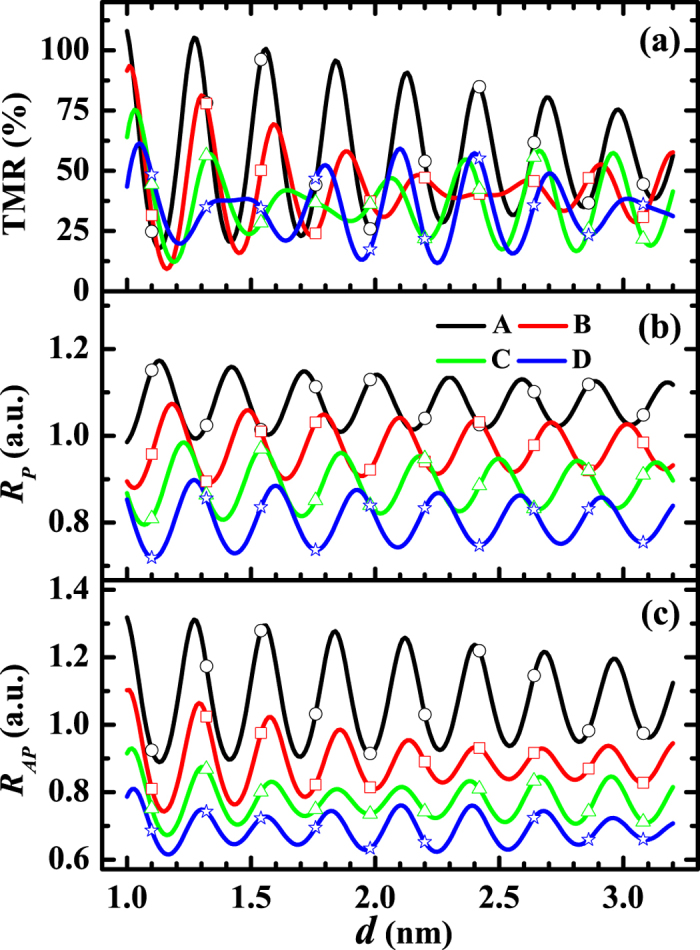
Thickness dependence of TMR, RP and RAP with the variation of μ.(a) TMR, (b) RP and (c) RAP as functions of barrier thickness d where Kh = 2.116 × 1010 m−1, v(Kh) = 16 eV and Δ = 9 eV. The curves A, B, C, and D correspond to μ = 10 eV, 11 eV, 12 eV and 13 eV, respectively. The data corresponding to the discrete layers of the grating barrier are marked with open symbols: curve A is marked by open circle, curve B is marked by open square, curve C is marked by open triangle, and curve D is marked by open star.